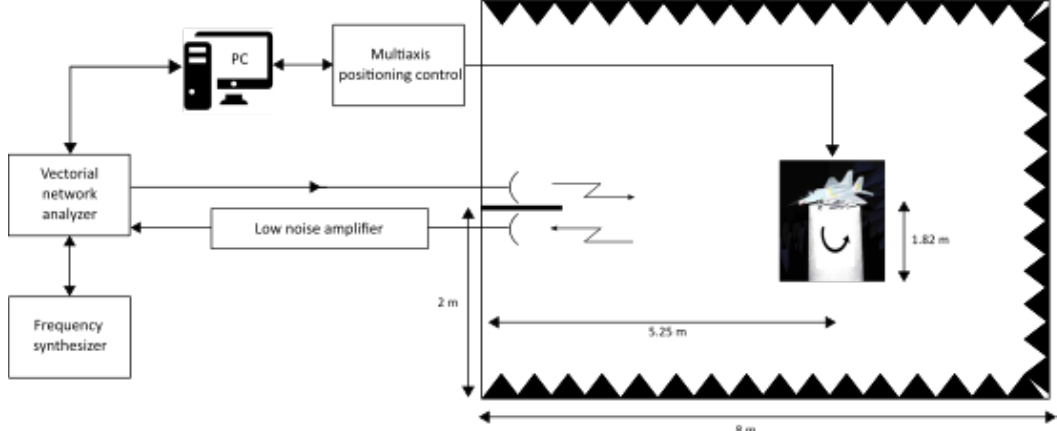
Figure 3. Experimental setup of the anechoic chamber. Reproduced with permission from A. Toumi, Information sciences; published by ELSEVIER, 2012.